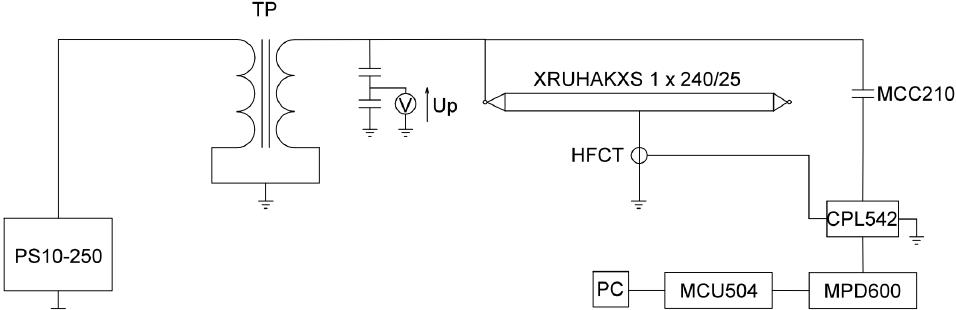
Figure 7. Scheme of the measurement